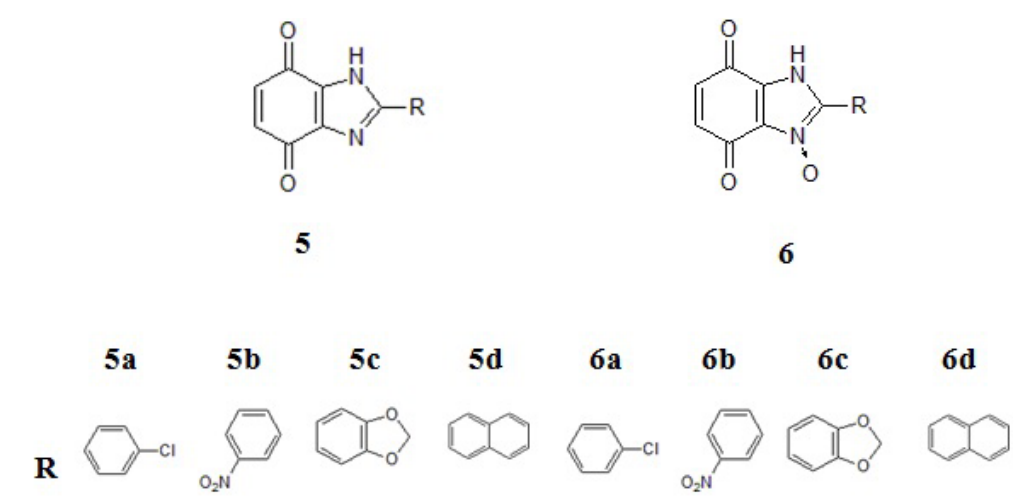
Figure 2. Structural formula of benzimidazole-4,7-dione derivatives. a : p -chlorophenyl, b : o -nitrophenyl, c : piperonyl, d :